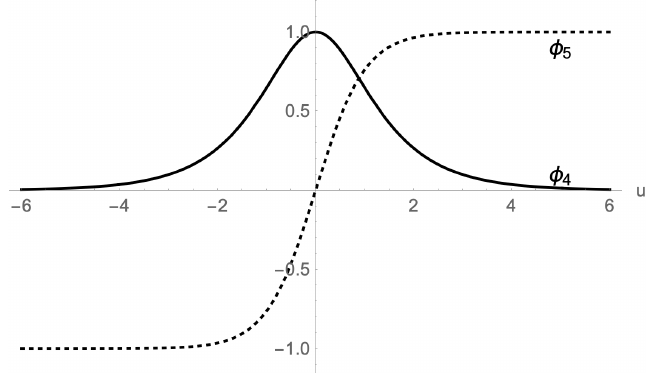
Figure 1 . Plot of φ 4 and φ 5 for ( p, q ) = (0 , 1)